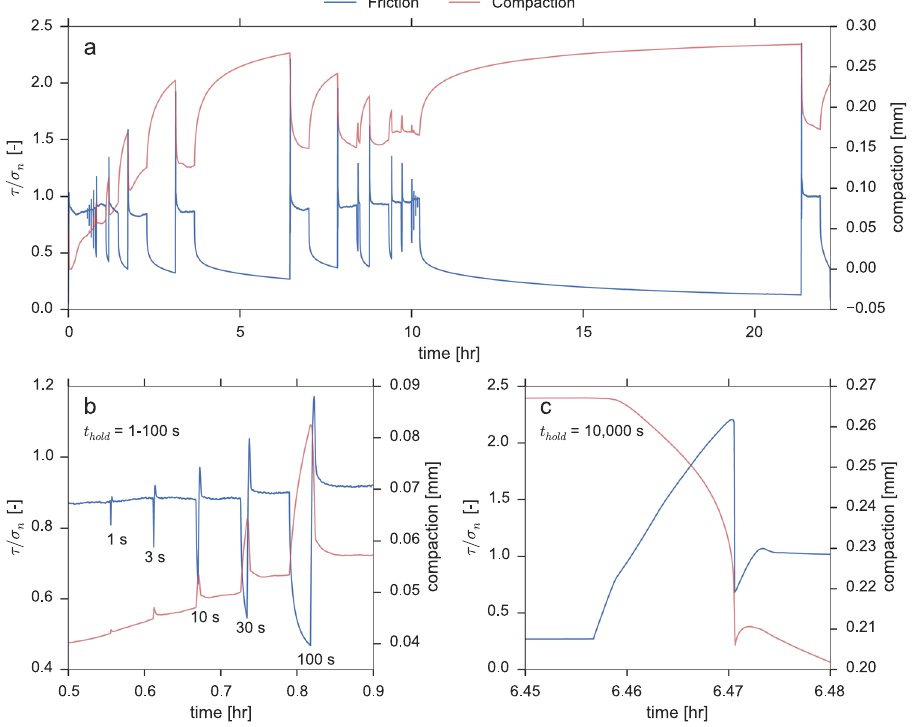
Figure 1. Mechanical results from experiment u473, conducted at a normal stress of 2.5 MPa. The blue lines display the apparent coefficient of friction, τ / σ n , the red lines display the axial displacement as recorded by